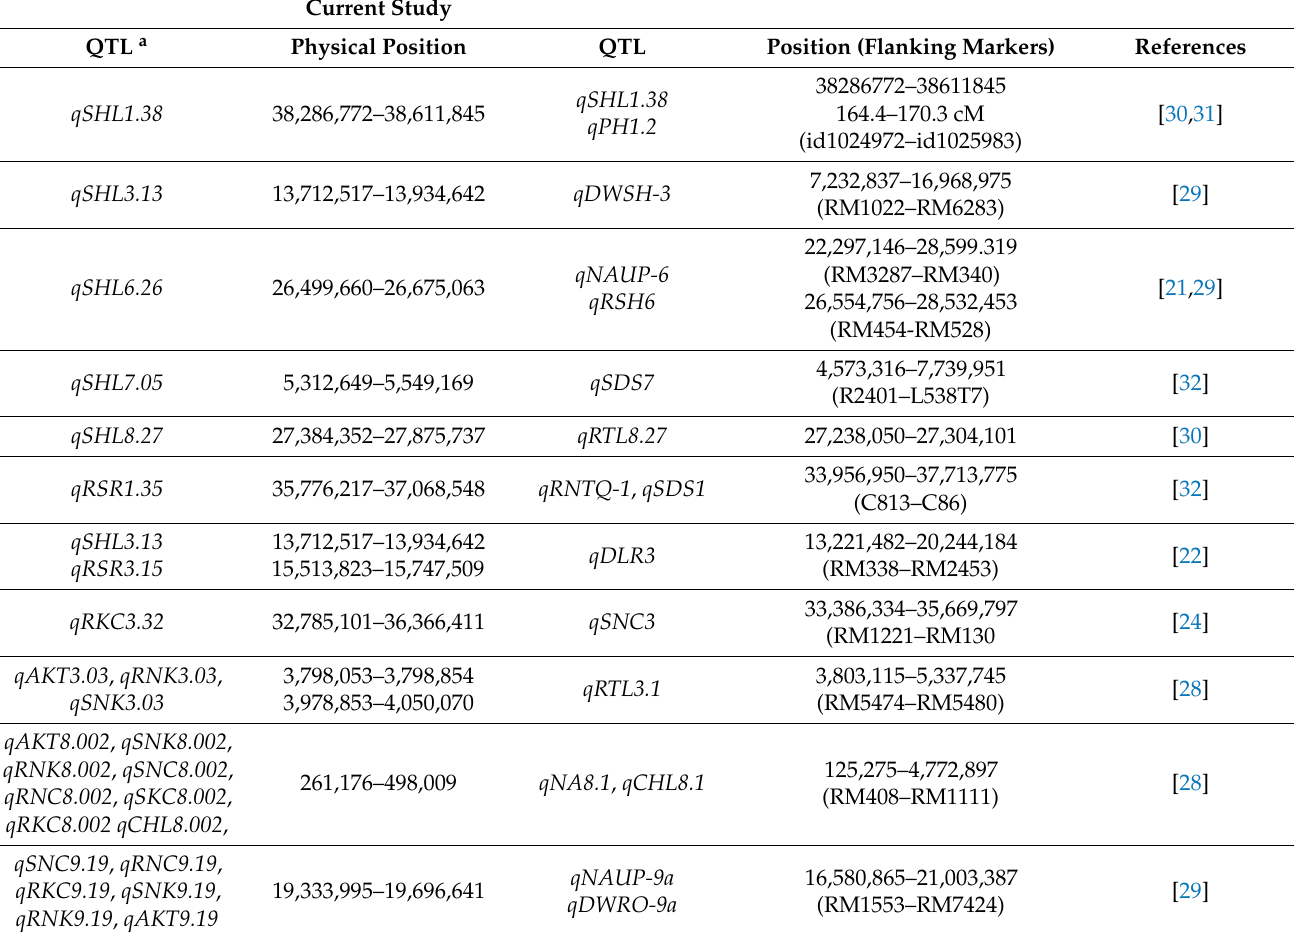
Table 4. List of previously reported QTLs colocalized with the QTLs detected in this